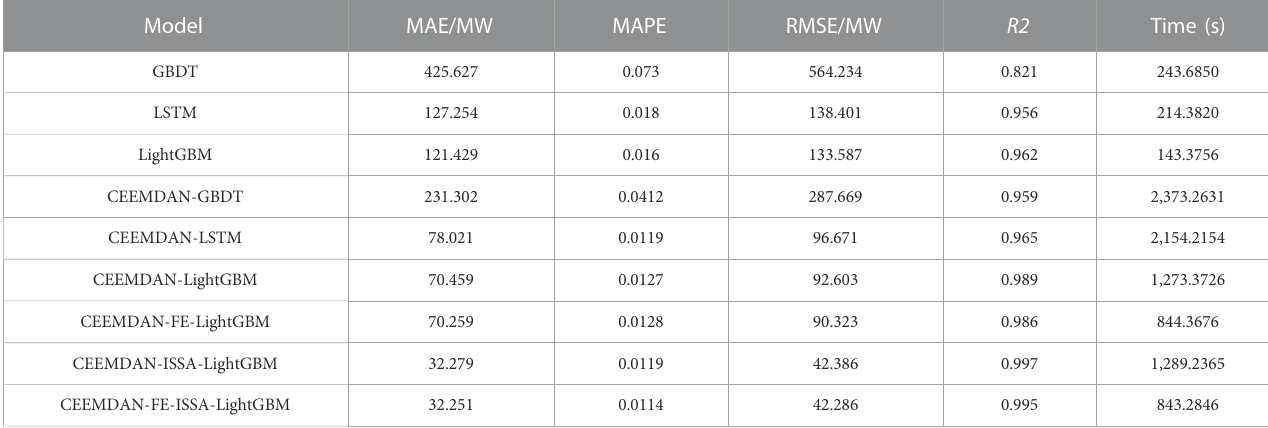
TABLE 4 Error of the proposed model versus a single model in Case 1.